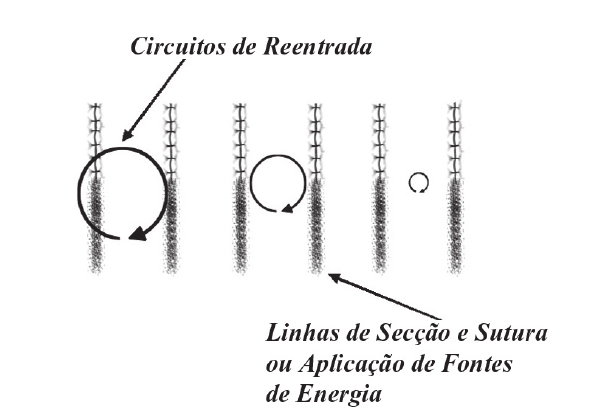
Fig. 2 - Esquema representando: as linhas de secção e